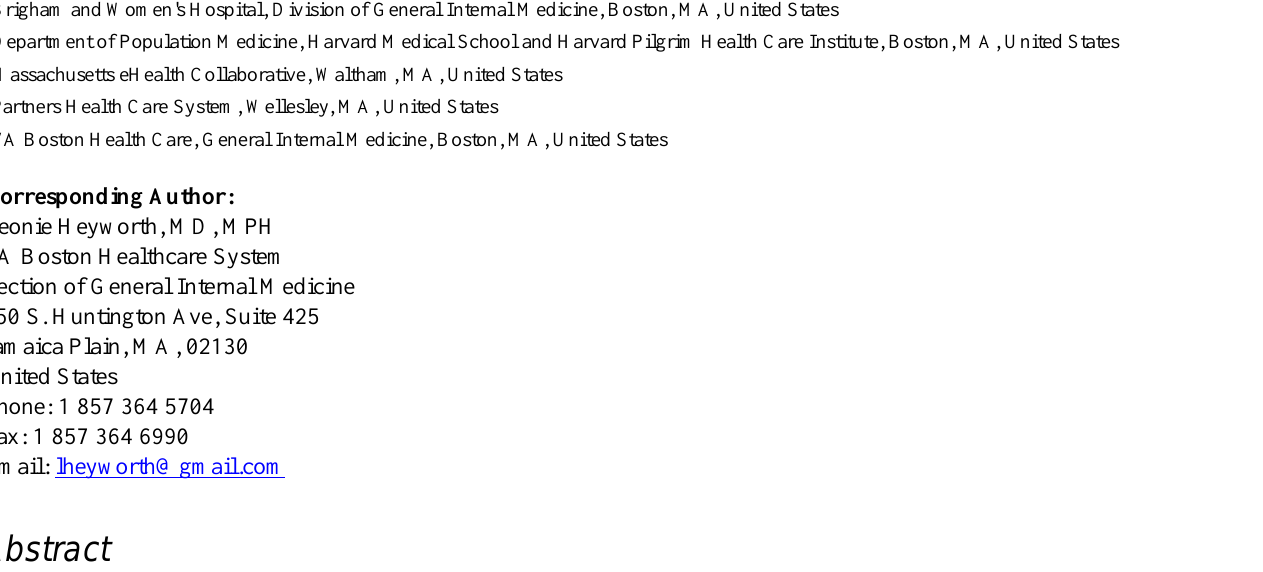
electronic health record; physician satisfaction; implementation; Massachusetts eHealth